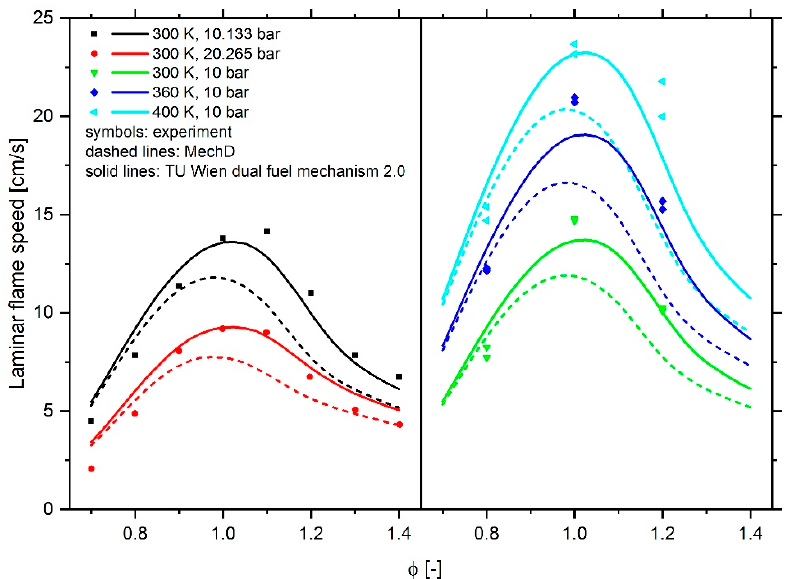
Figure 23. Measured laminar flame speeds of methane–air mixtures [112] as function of the fuel–air equivalence ratio φ in comparison with simulated values before (MechD; dashed lines) and after the Arrhenius parameter adaption of reactions 1, 25, and 56 (TU Wien dual fuel mechanism 2.0; solid lines).